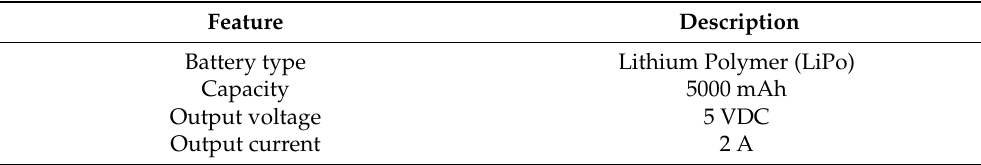
Table 4. Main features of the embedded system’s power